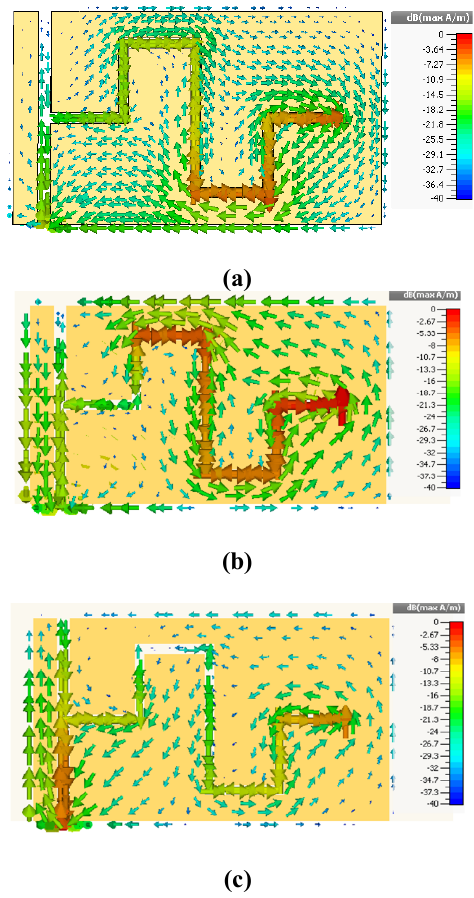
Figure 8: Illustration of current distribution on the proposed PIFA at (a) 0.9 GHz, (b) 1.8 GHz and (c) 2.45 GHz.